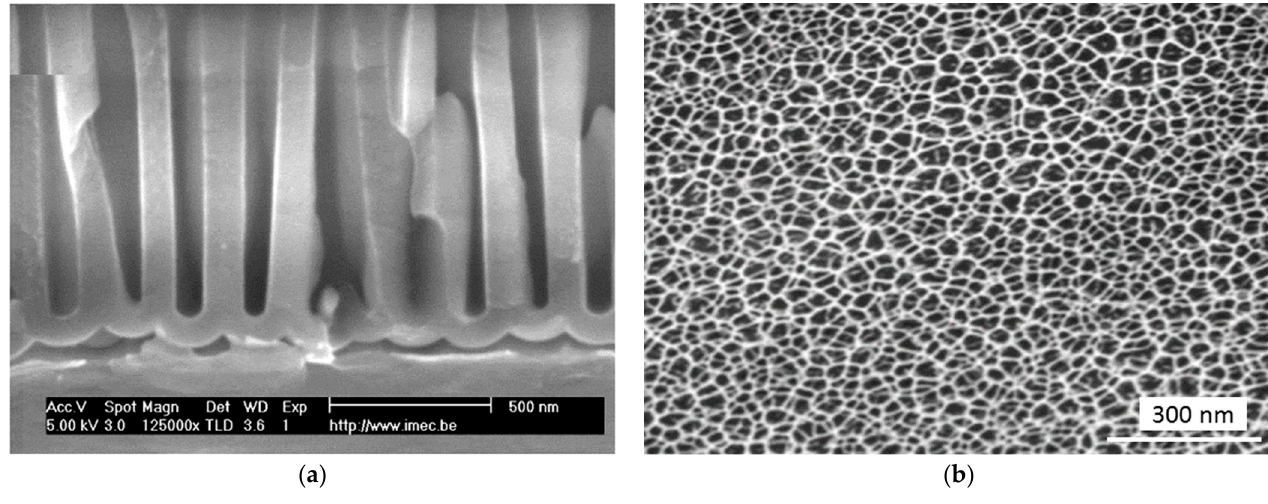
Figure 4. Image of real nanosized pores ( a ) in the cross section of the anodized layer; ( b ) their top view. Reprinted from Ref. [53].